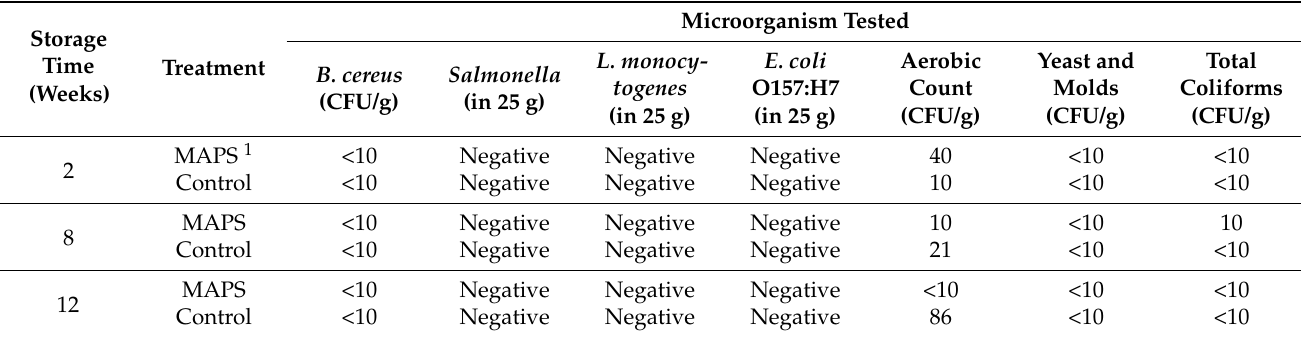
Table 3. Pathogens and spoilage-related microbial analyses conducted on the MAPS-processed jambalaya and the control during 12 weeks of storage at 2 ◦ C and − 31 ◦ C,